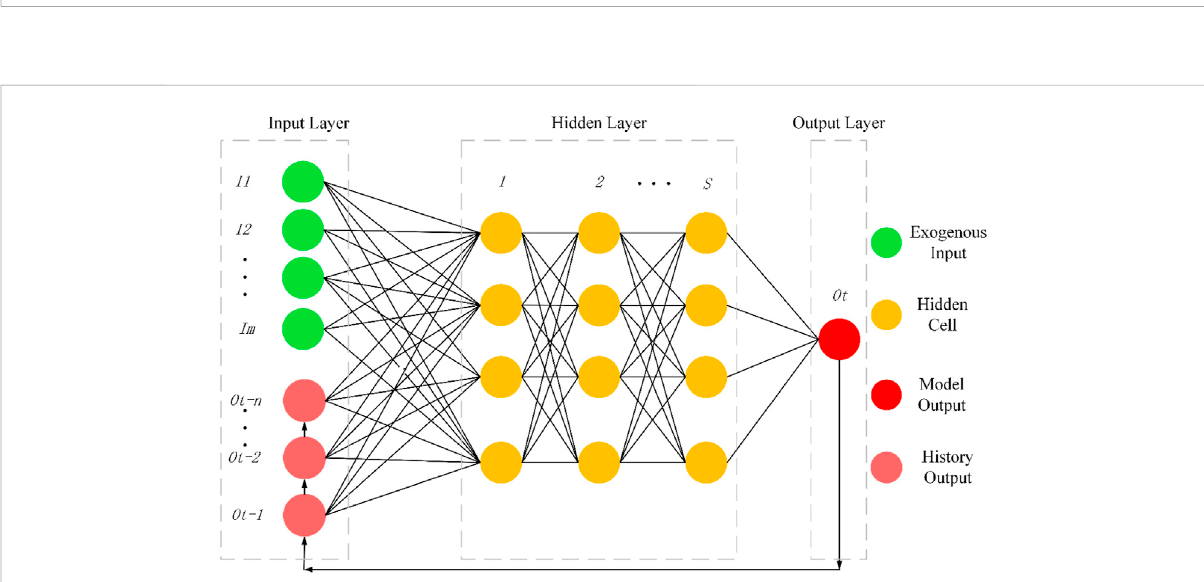
FIGURE 3 Architecture of the NARXNN model con fi gured with the m exogenous input variable, n time-delayed output variable, and S hidden layer.